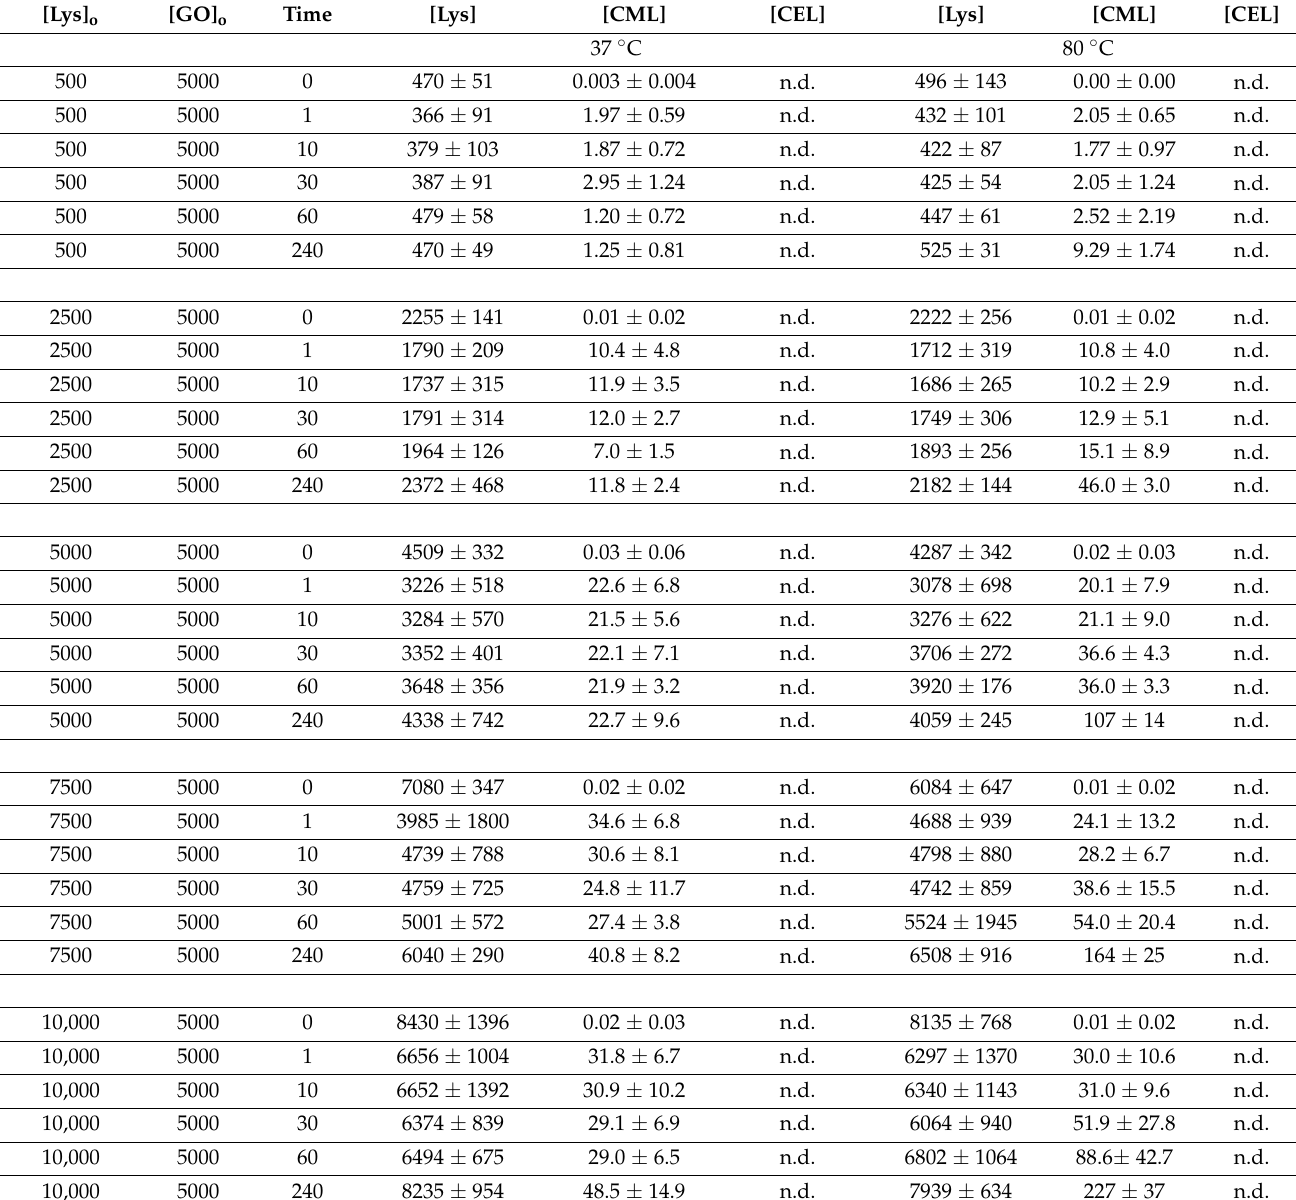
Table 1. Concentration (mean ± SD; µ M) of remaining Lys and formed CML and CEL from the reaction of Lys and GO at initial concentrations of 500–10000 µ M and 5000 µ M, respectively, at 37 ◦ C at 80 ◦ C for the indicated times (min) in 100 mM phosphate buffer (pH 7.4). n.d., not